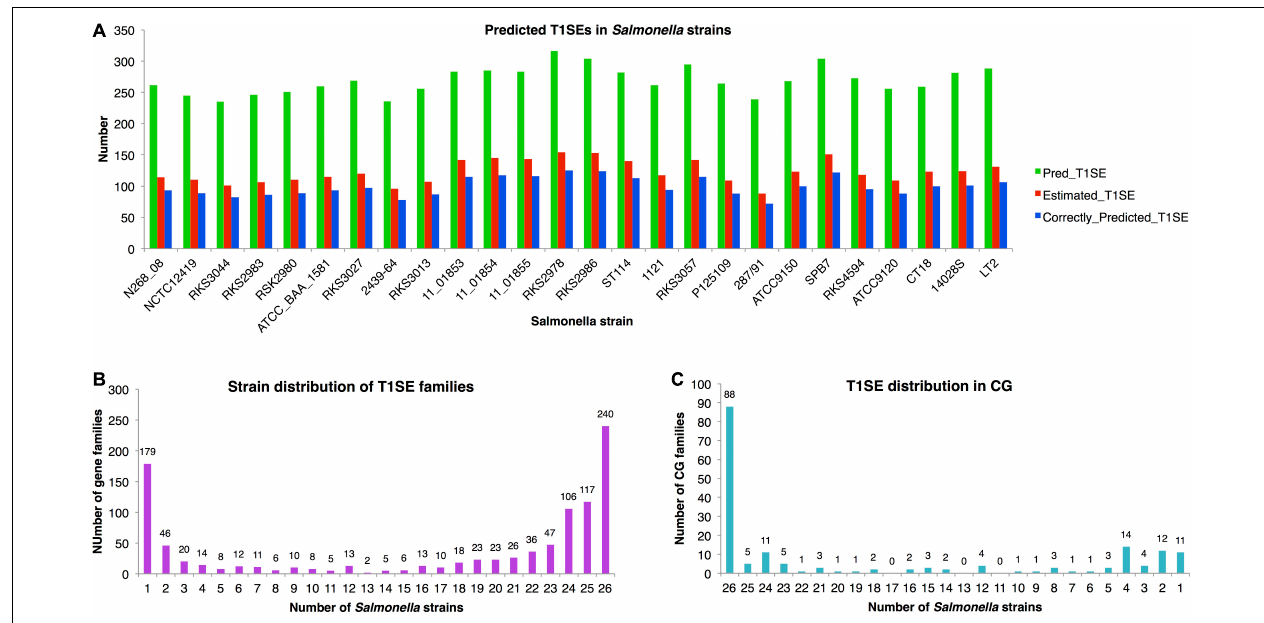
FIGURE 7 | Distribution of T1SE candidates predicted from Salmonella strains with T1SEstacker. (A) Number of predicted T1SEs, estimated real T1SEs, and correctly predicted T1SEs in Salmonella strains. (B) The orthologous family distribution of T1SEs in Salmonella strains. (C) Distribution of core-genome T1SE hits in Salmonella strains. CG, core